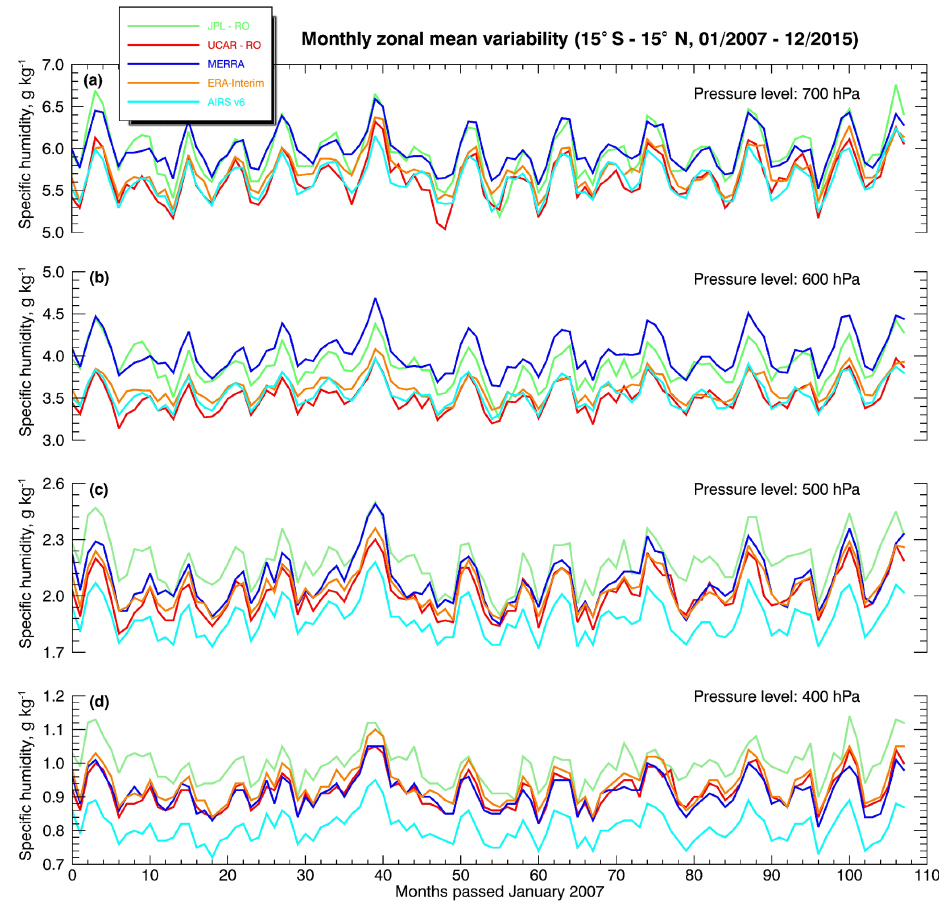
Figure 1. Times series of the monthly zonal averages of the specific humidity from 1 January 2007 until 31 December 2015 from JPL (green), UCAR (red), ERA-Interim (orange), MERRA (blue), and AIRS (cyan) at (a) 500hPa, (b) 400hPa, (c) 700hPa, and (d) 600hPa pressure